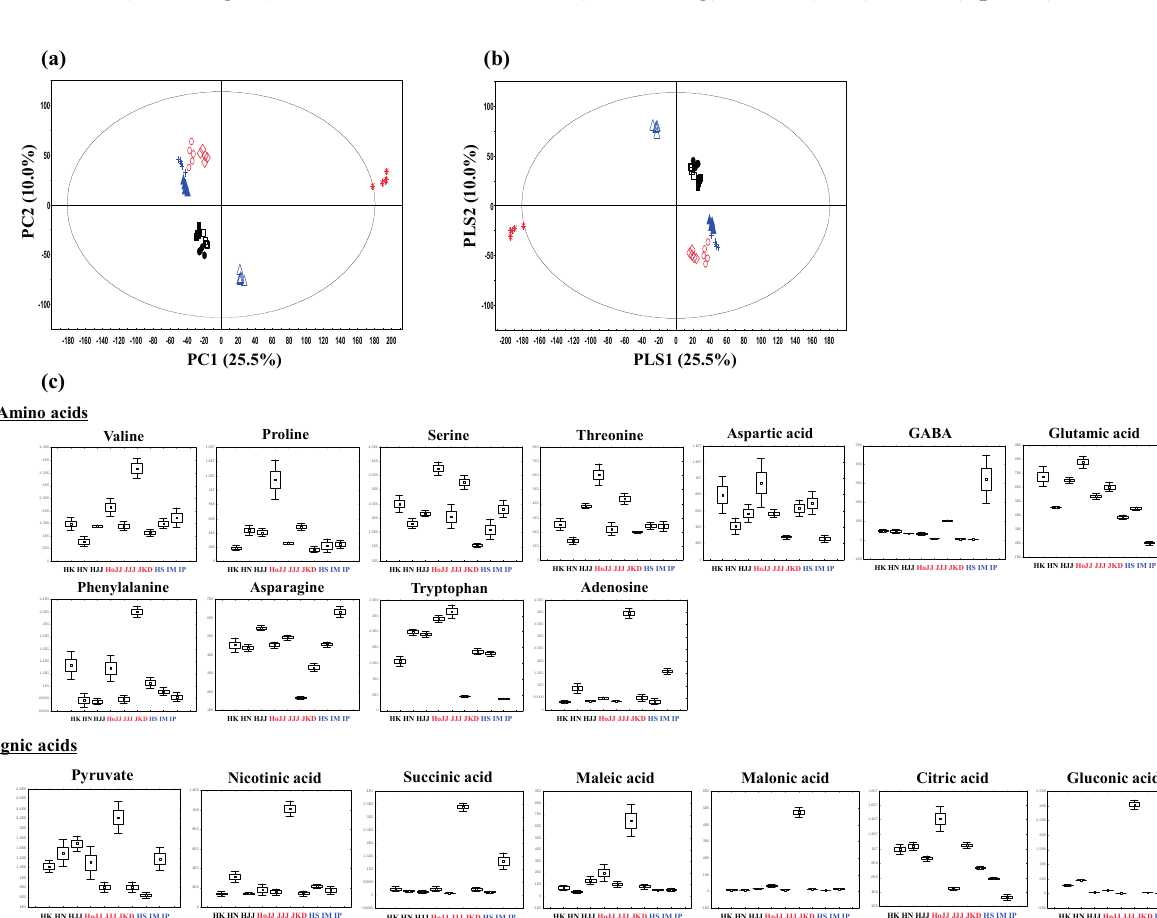
Figure 2. The principal component analysis (PCA) score plots ( a ), partial least-square discriminant analysis (PLS-DA) score plots ( b ), and box-whisker plots ( c ) of nine different varieties of rice seeds analyzed by UPLC-Q-TOF-MS. Black rice seed: ● HK (Heugkwang), □ HN (Heugnam), ■ HJJ (Heugjinju); Red rice seed: ◇ HoJJ (Hongjinju), ○ JJJ (Jeogjinju), ж JKD (Jakwangdo); White rice seed: ▲ HS (Hwaseong), + IM (Ilmi), △ IP